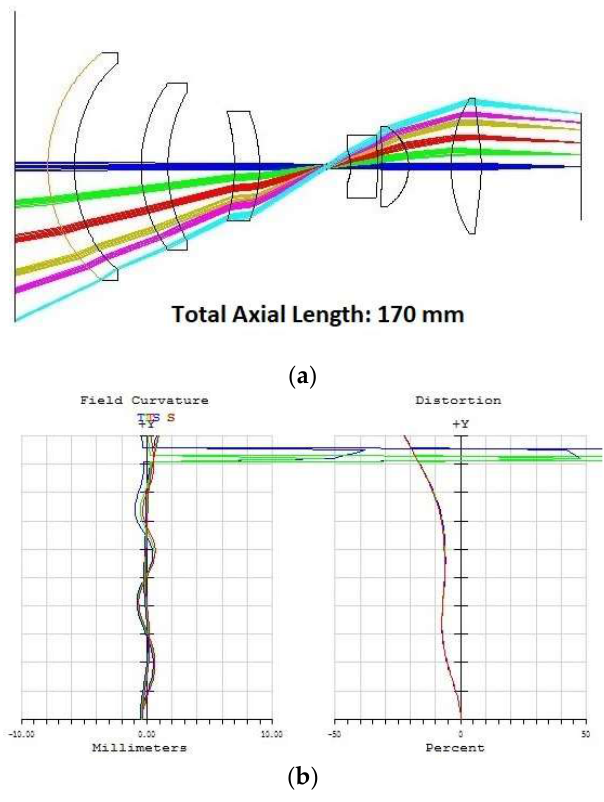
Figure 8. ( a ) Result of the iterative optimization process; ( b ) Resultant field curvature and distortion curves.